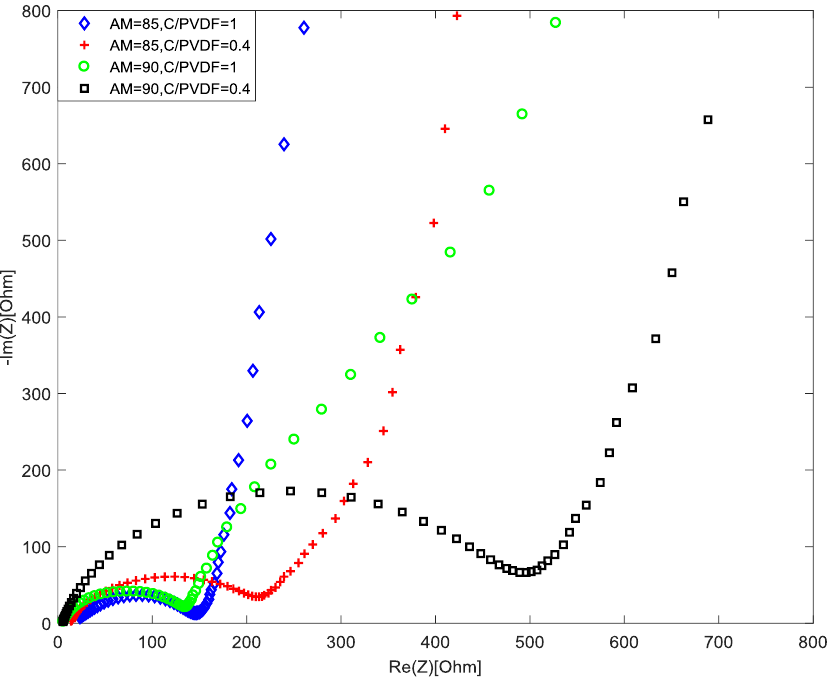
Figure 3. EIS spectra with different C/PVDF ratios at 3.5 V. Table 4. Impedance model and the values of circuit elements.